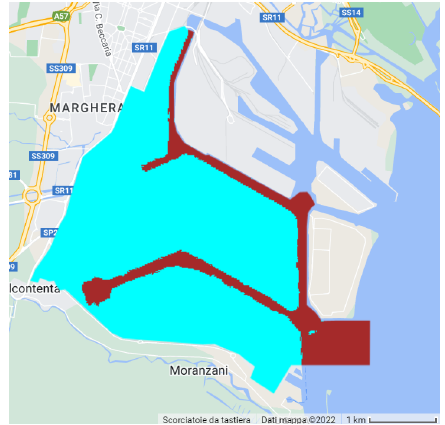
Figure 4. Water segmentation image obtained with the AWEI approach using Sentinel imagery.